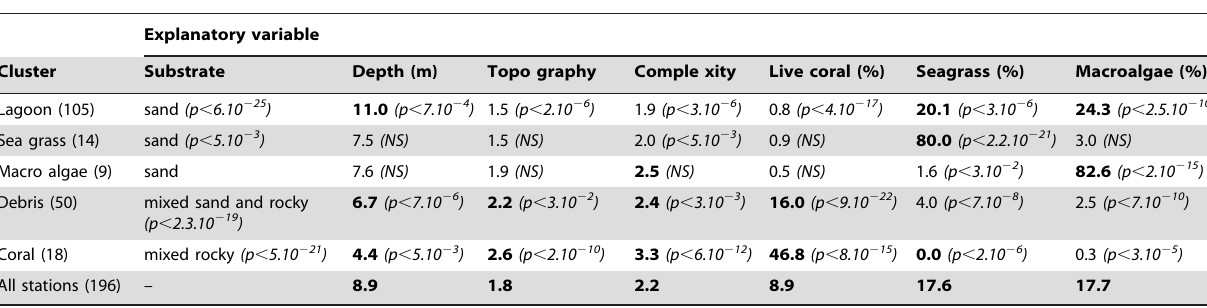
Table 4. Description of the habitat clusters resulting from the